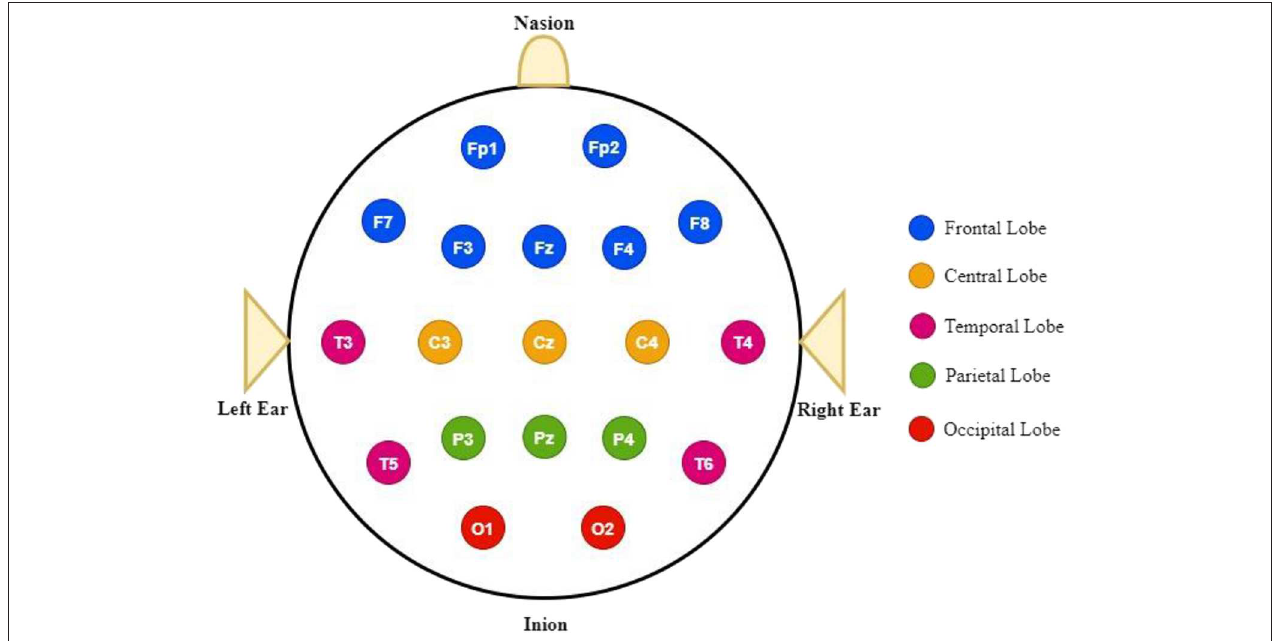
FIGURE 3 | Standardized electrode placement scheme.